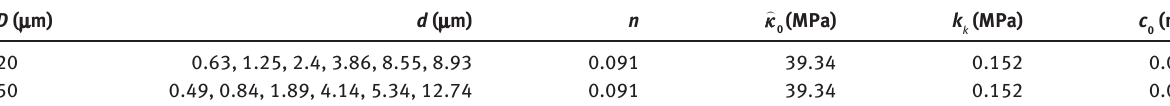
Table 2: Parameter values for modeling torsion experimental data [11] using Eq. (14). D ( μ